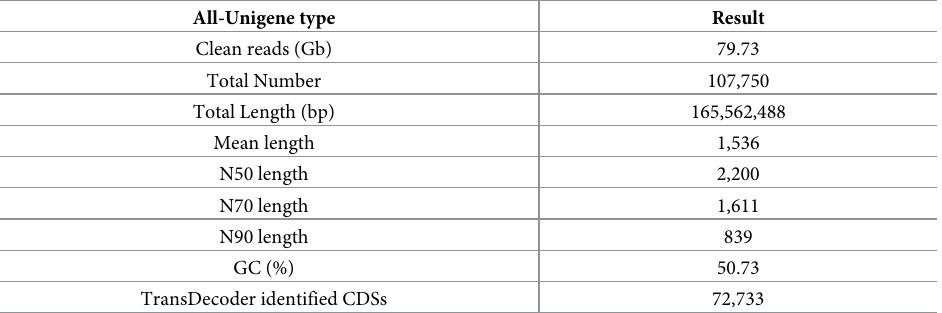
Table 1. Overview of the assembled sugarcane transcriptome from healthy and Leifsonia xyli subsp. xyli infected plant